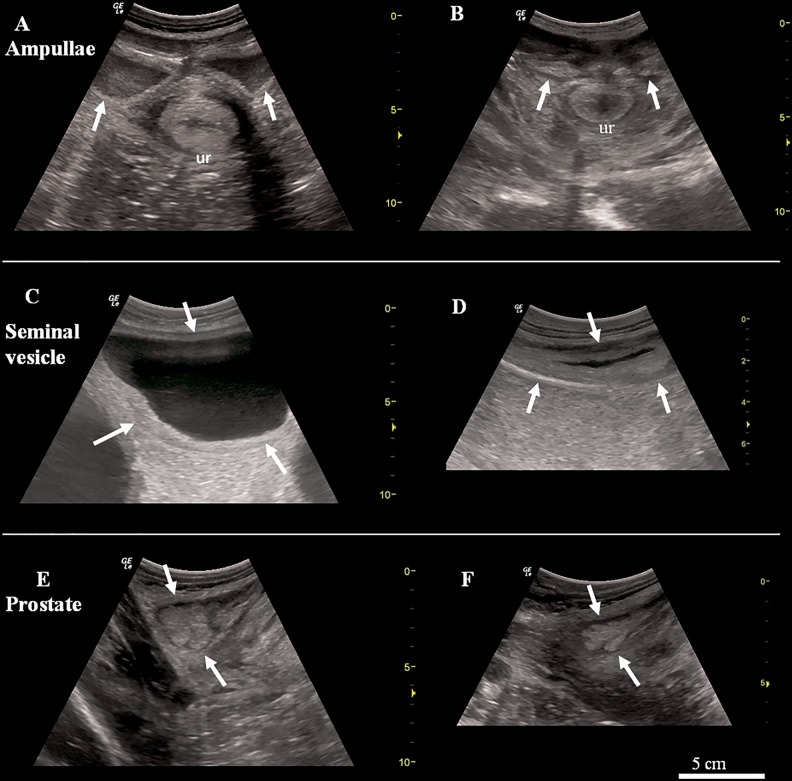
Ultrasonographic images of elephant bull accessory sex glands before and after GnRH vaccination: (A) prior to GnRH vaccination: sperm and fluid filled right and left ampullae of the ductus deferens (arrows) just before joining the urethra (ur) and (B) after 3 GnRH vaccine treatments, when ampullae yield no content anymore; (C) Large fluid filled seminal vesicles (arrows) prior to GnRH vaccination and (D) smaller size of the seminal vesicles and fluid content reduction after 7 vaccinations; (E) left prostatic lobe (arrows) after 2 vaccinations and (F) after 7 GnRH injections, note the size reduction. Image size adjusted to same scale (see scale bar).